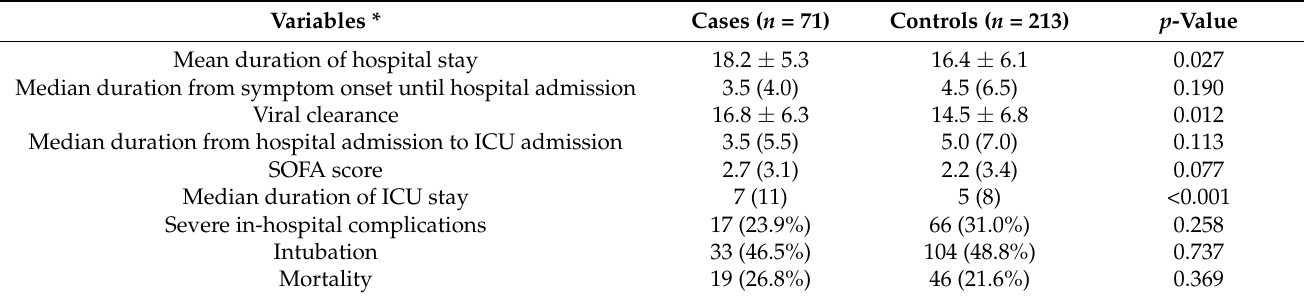
Table 3. Comparison of COVID-19 outcomes between patients of cases and controls admitted to the ICU.